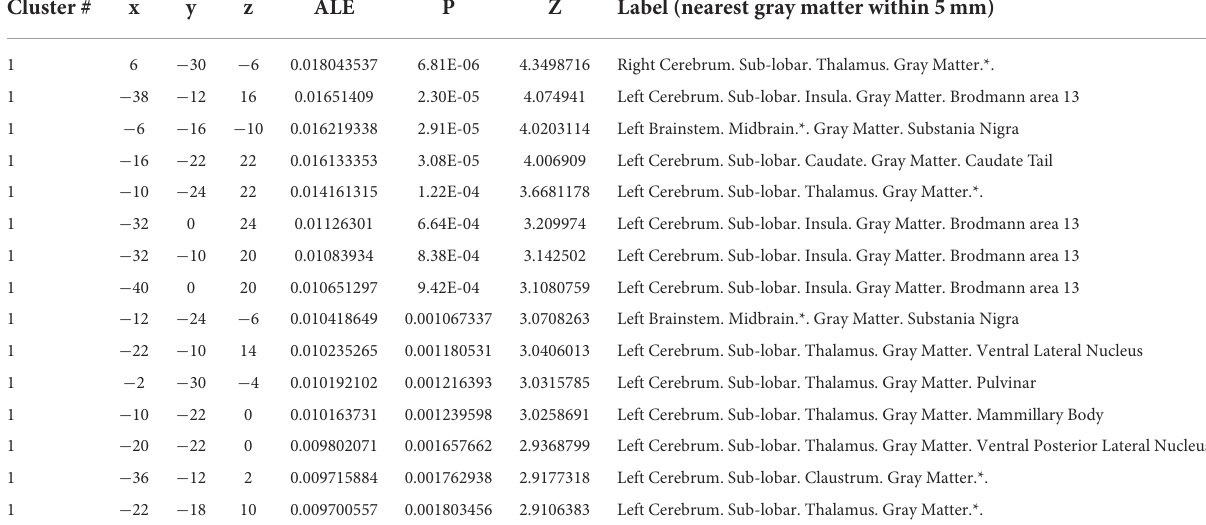
*Clustersoutsidethebrainatlas.